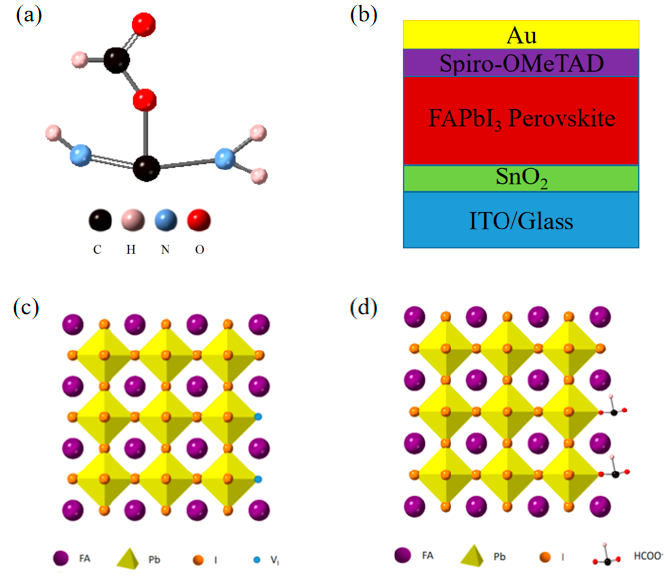
Figure 1. ( a ) Chemical structure of FAHCOO. ( b ) Device structure diagram of an FAPbI 3 solar cell. ( c , d ) Schematic diagram of an FAPbI 3 perovskite without ( c ) or with ( d ) FAHCOO passivation.